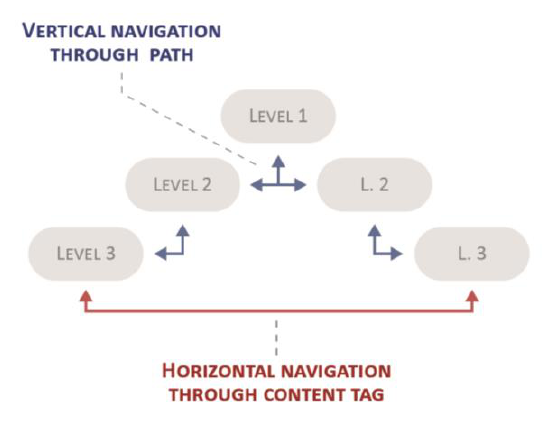
Figure 2. Vertical and horizontal navigation within the